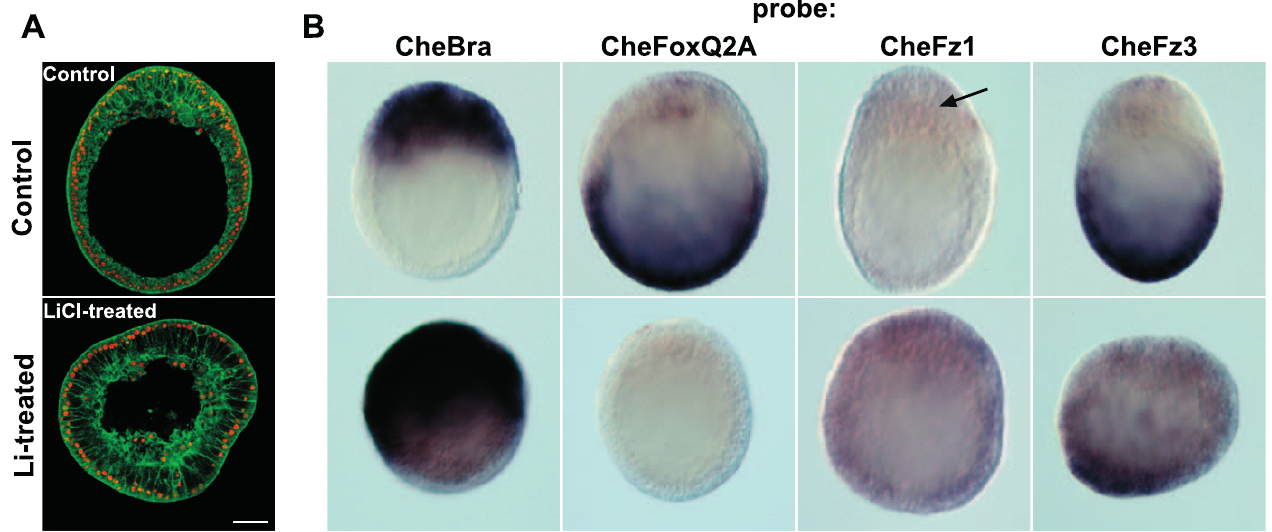
Figure 6. Global b -Catenin Stabilisation Uncouples Oralisation from CheFz RNA Levels (A) Confocal images of phalloidin/ToPro3-stained early gastrula embryos (see Figure 2) showing characteristic phenotypes obtained following Wnt pathway activation by treatment with 50 mM LiCl from the two-cell stage (bottom row) compared with untreated controls (top row). (B) Representative in situ hybridisation images of control and LiCl-treated embryos fixed at the early gastrula stage, with probes as indicated (weak oral CheFz1 expression indicated by arrows in controls).